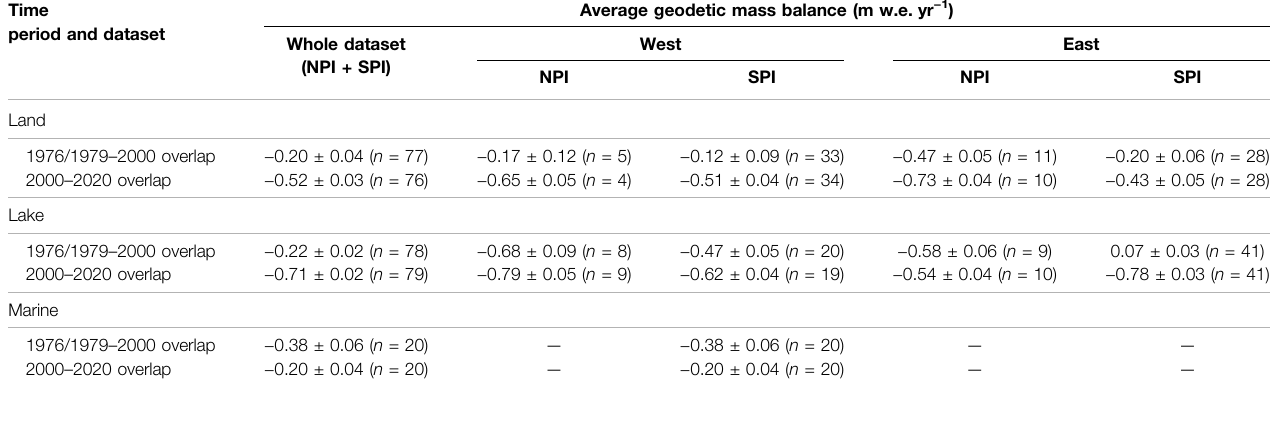
TABLE 4 | Geodetic mass balance averages (not area-weighted) for NPI and SPI glacier aggregations described by terminus type and location relative to the ice divide. Time period and